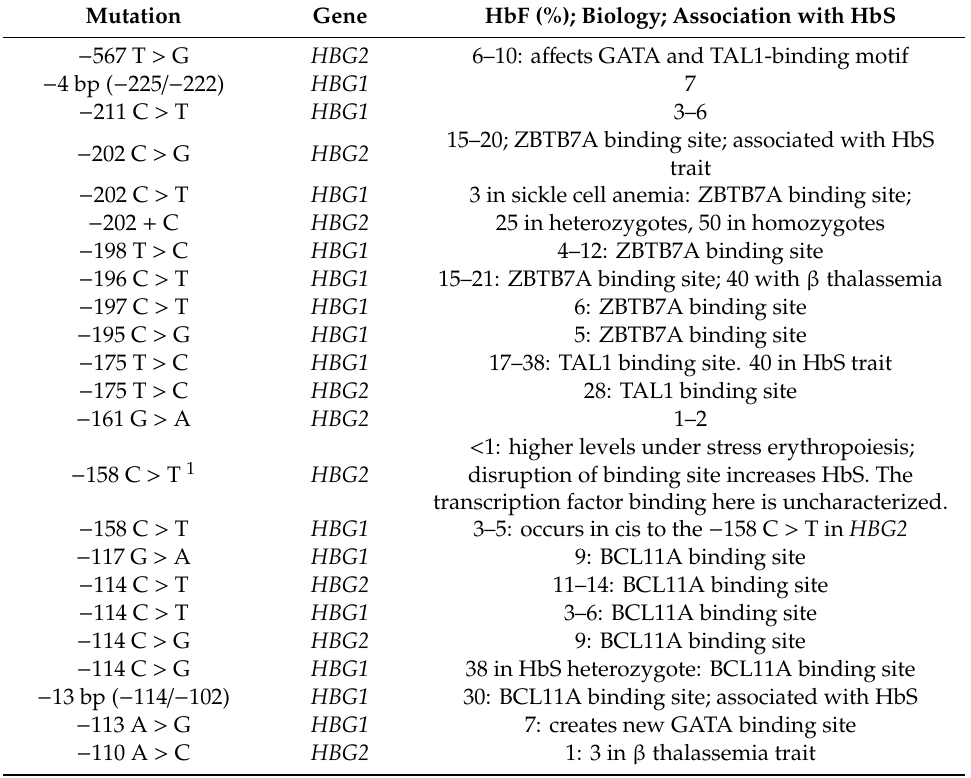
Table 2. Point mutations in HBG2 and HBG1 promoters and the polymorphism in the HBG2 promoter that have been associated with increased HbF in heterozygotes and compound heterozygotes with HbS. Approximate HbF levels are